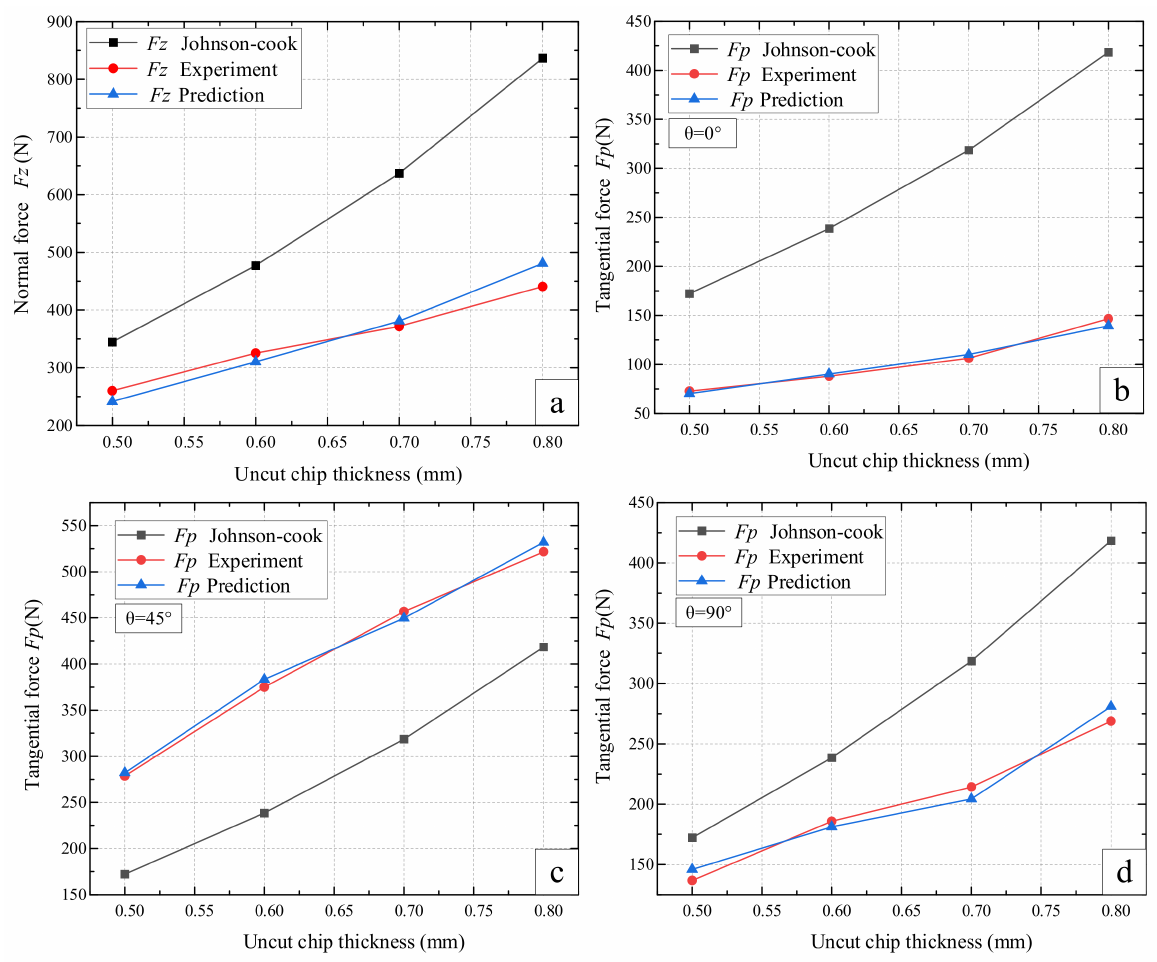
Figure 7. Comparison of isotropy and anisotropy modeling on bone cutting force: ( a ) comparison of different model on normal force; ( b – d ) comparison of different modeling on tangential